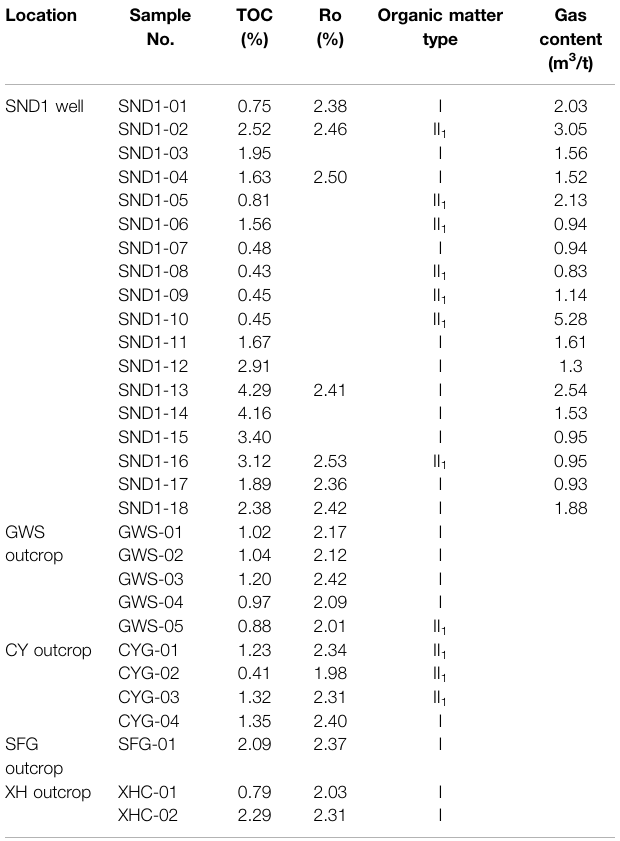
TABLE 1 | Organic geochemical characteristics and gas content of the Niutitang Formation shale gas in the study area. Location Sample